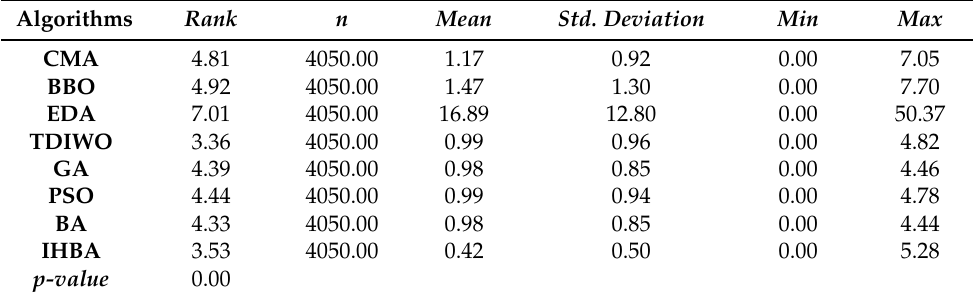
Table 11. The Descriptive Statistics Achieved by the Friedman Test at C = 60 and α = 0.05. The bold figures indicate the comparison between algorithms.